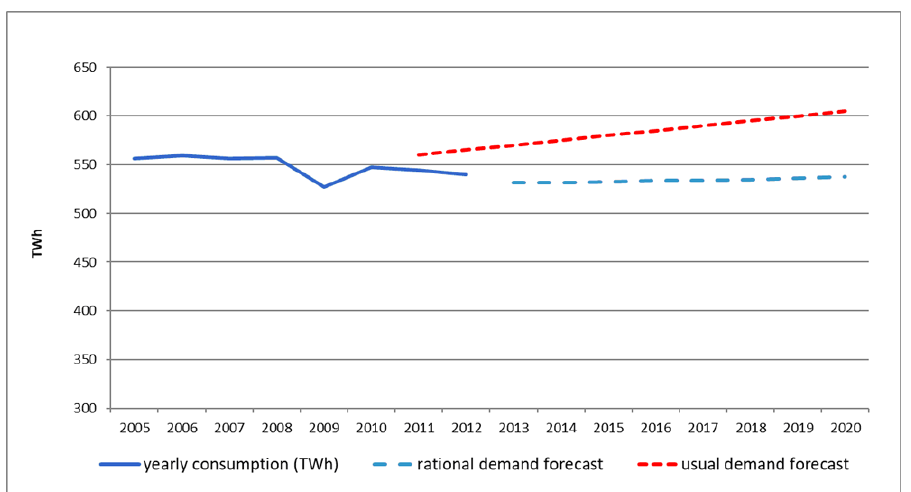
Figure 5. Germany, consumption by year, real data, modeled forecast, and usual demand forecast based on [17].